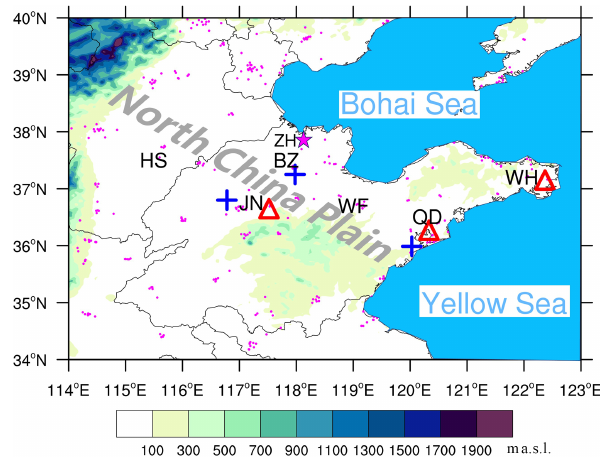
Figure 1. Topography of North China Plain (NCP; unit: m a.s.l., indicated with different colors (color bar)) and locations of cities Hengshui (HS), Jinan (JN), Binzhou (BZ), Weifang (WF), Qingdao (QD), and Weihai (WH). Three radar stations, located in JN, QD, and WH, are marked by red triangles. The ground-based air quality monitoring stations are shown by magenta dots, and the station with high-frequency measurement of air quality located in Zhanhua (ZH) county of Binzhou city is marked by a magenta star. The locations of Bohai Sea and the Yellow Sea are also indicated. The thin gray lines indicate the borders of